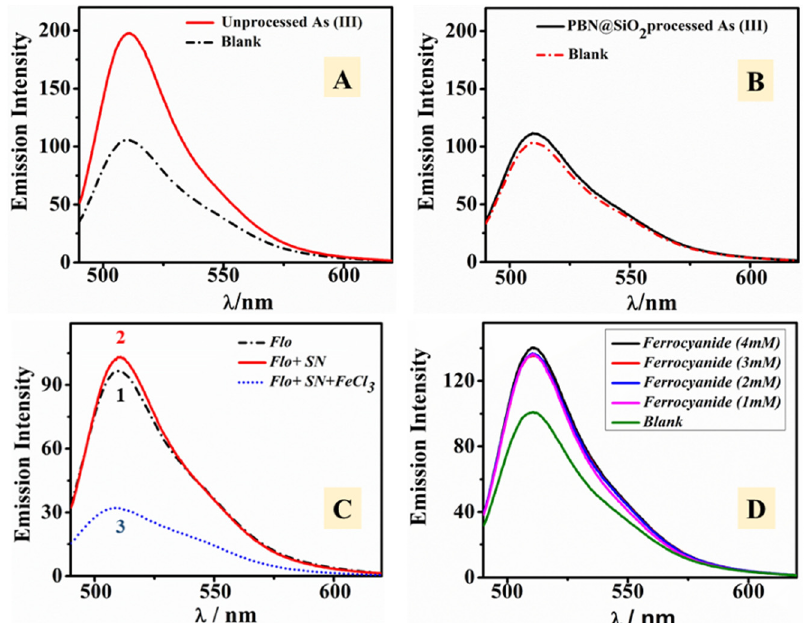
Figure 9. Fluorescence emission spectra of Flo with unprocessed ( A ) and PBN@SiO 2 processed ( B ) As(III) solution. Identification of ferrocyanide species in supernatant on the addition of ferric chloride via fluorescence quenching ( C ). Study of the effect of ferrocyanide species (1–4 mm) over Flo emission spectra ( D ).